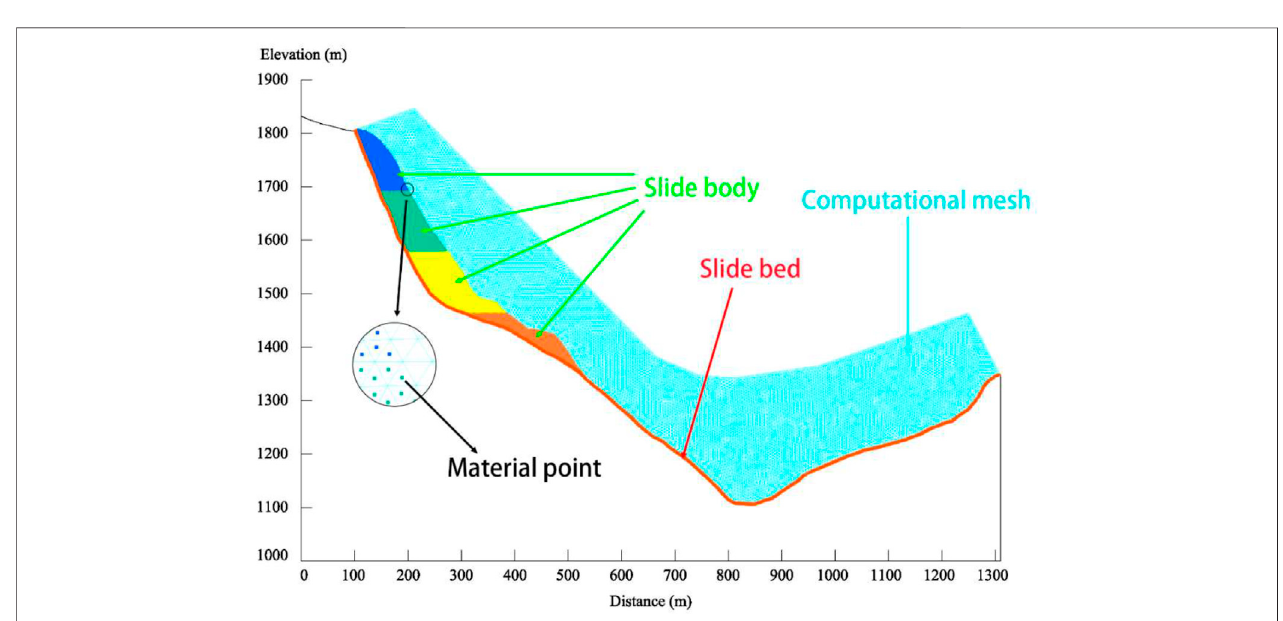
FIGURE 6 | MPM model of the Hongshiyan